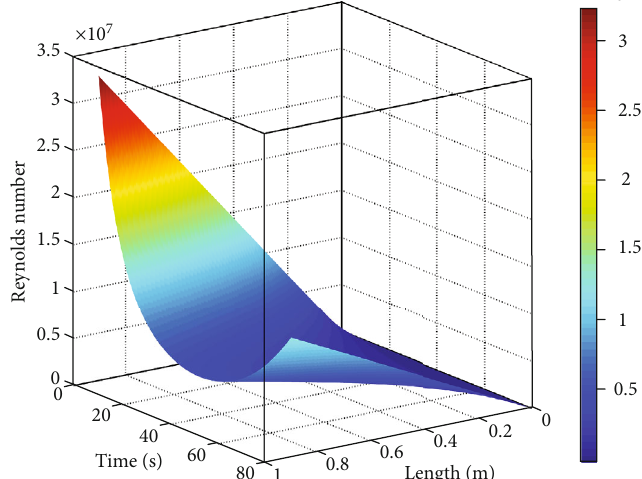
Figure 5: 3-D distribution of the Reynolds number.